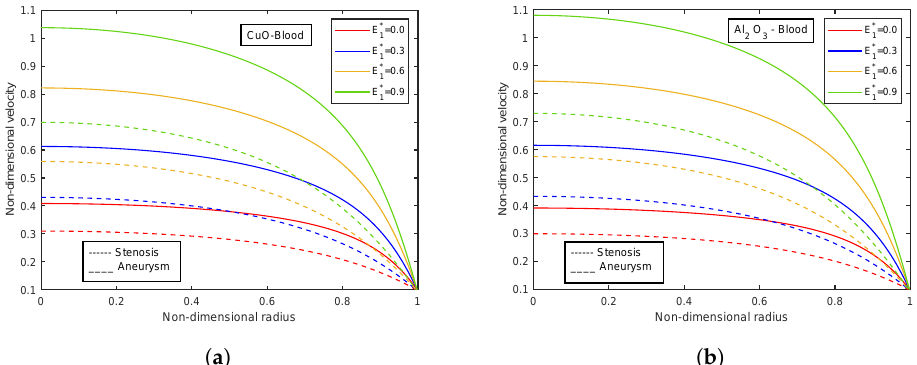
Figure 12. Velocity profiles of electric field parameter E ∗